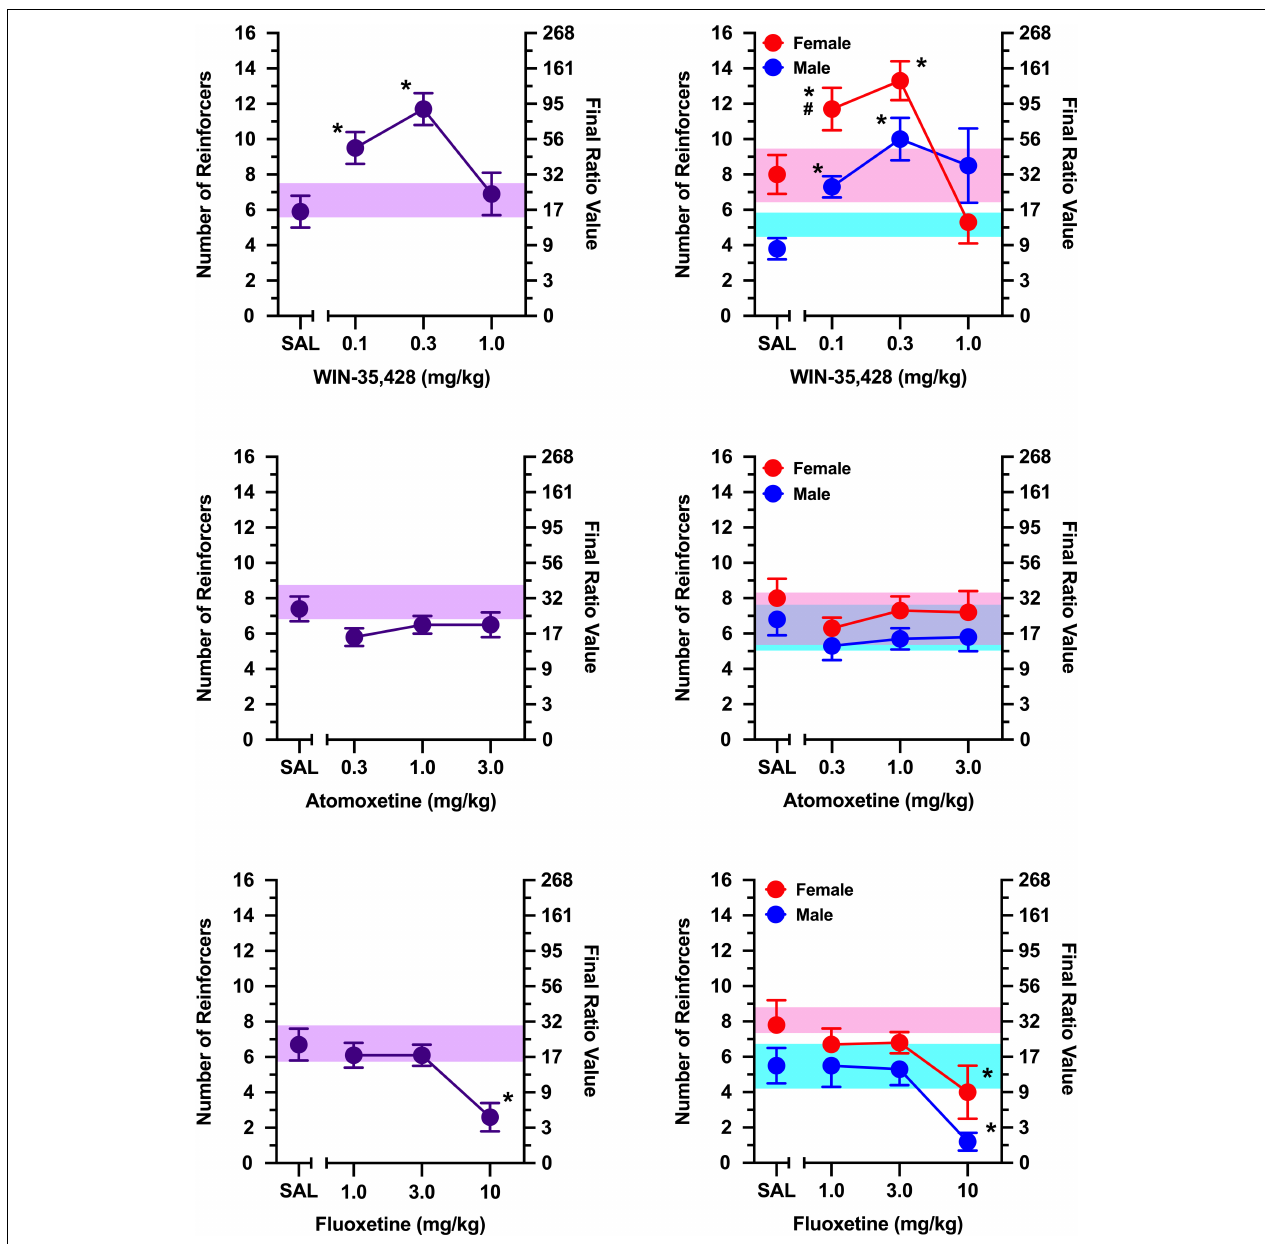
FIGURE 2 | The effects of WIN-35,428 (top) , atomoxetine (middle) , and fluoxetine (bottom) on breakpoints maintained by a social stimulus (i.e., sex- and age-matched partner). Left panels depict data collapsed across males and females. Right panels depict data collected in males and females separately. Left axes reflect breakpoint defined as the number of reinforcers obtained; right panels depict breakpoint as final ratio value completed. Bottom axes represent the effects of saline (SAL) and doses of WIN-35,428, atomoxetine, and fluoxetine expressed in mg/kg. Vertical lines extending from data points represent the SEM. Asterisks (*) indicate significant difference relative to saline. Number sign ( # ) indicates significant difference relative to male rats. Shaded regions indicate variance in breakpoint during non-injection control sessions (purple = collapsed across sex; blue = male; pink = female).